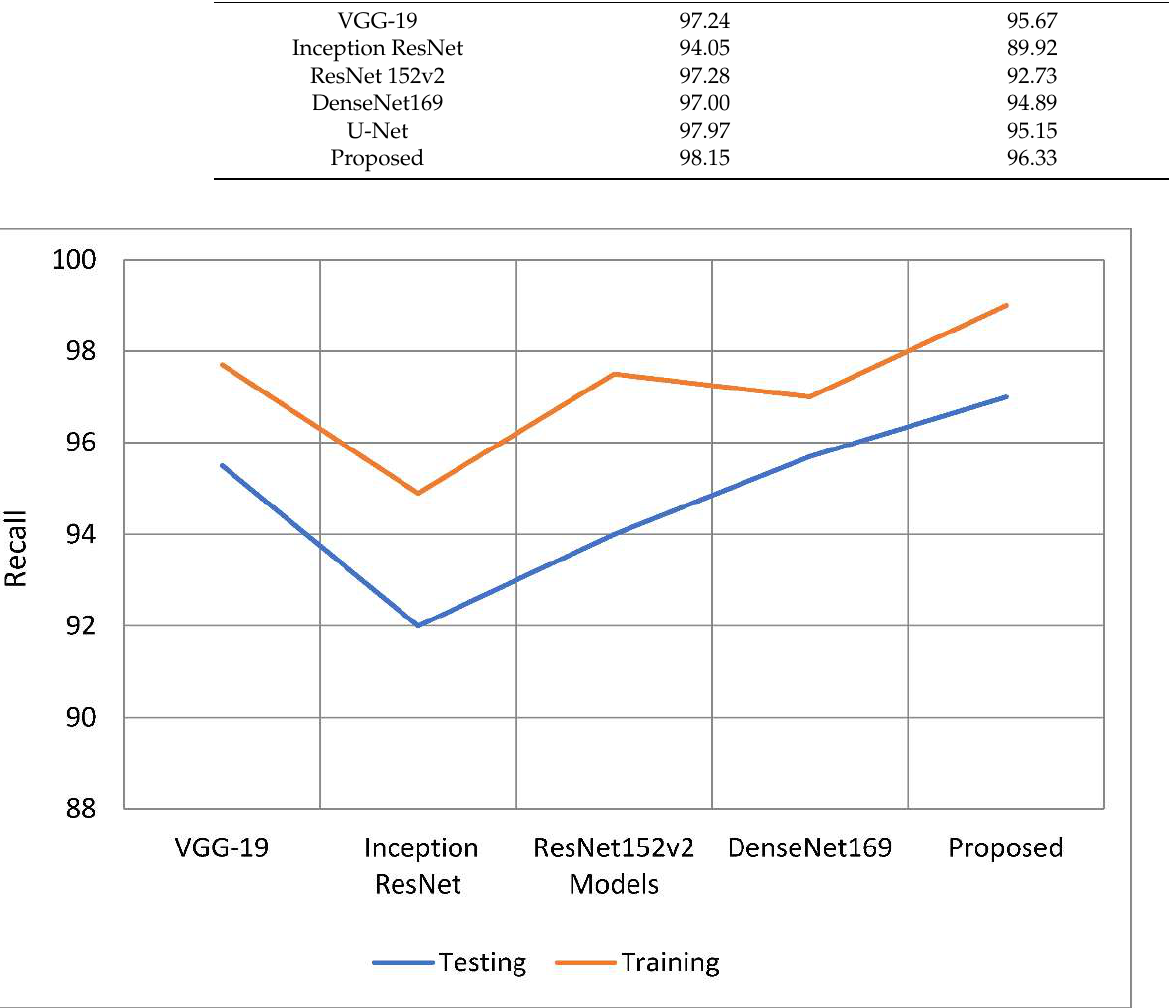
Figure 11. Comparative analysis of specificity of the proposed model with traditional models. An accurate prediction of the risk that an otherwise healthy individual would get infected with a disease is referred to as a model’s “specificity”. The total number of people whose samples were analyzed and found to be clear of the illness under consideration. Use the following equation to get a more accurate number for specificity. To establish the specificity of the test, just increase the total number of tests by one. The proposed model outperformed the other deep learning models in terms of specificity rates when compared to their total performance. The model has a 98.15 percent specificity rating compared to